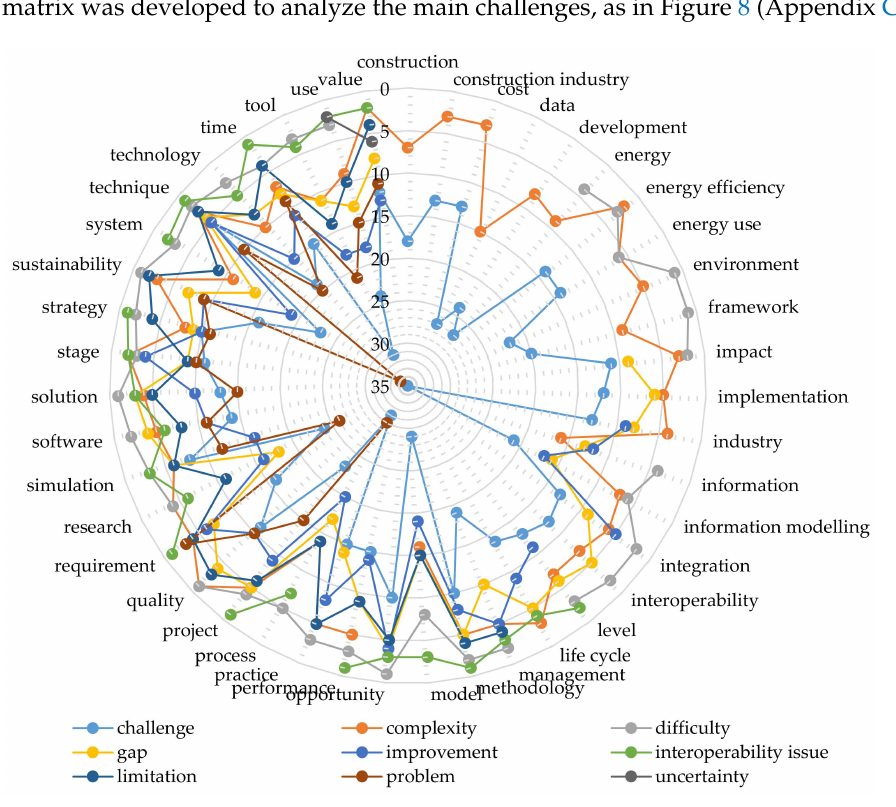
Figure 8. The challenges co-occurrence matrix in the BIM and building energy-efficient topic. Note: values of keywords co-occurrence are presented in reverse order to improve